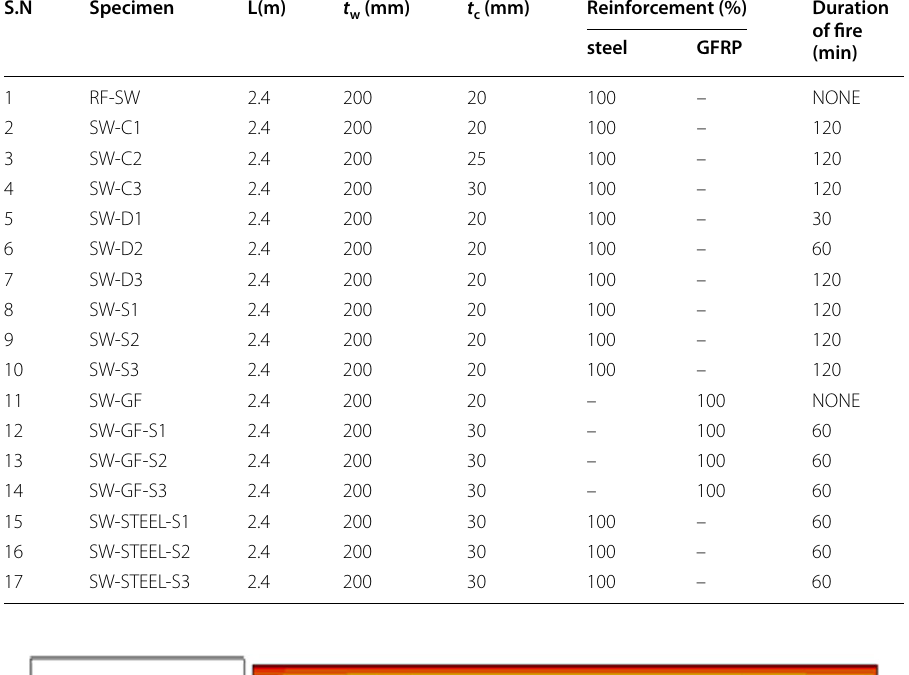
Table 2 Summary of parameters of the study S.N